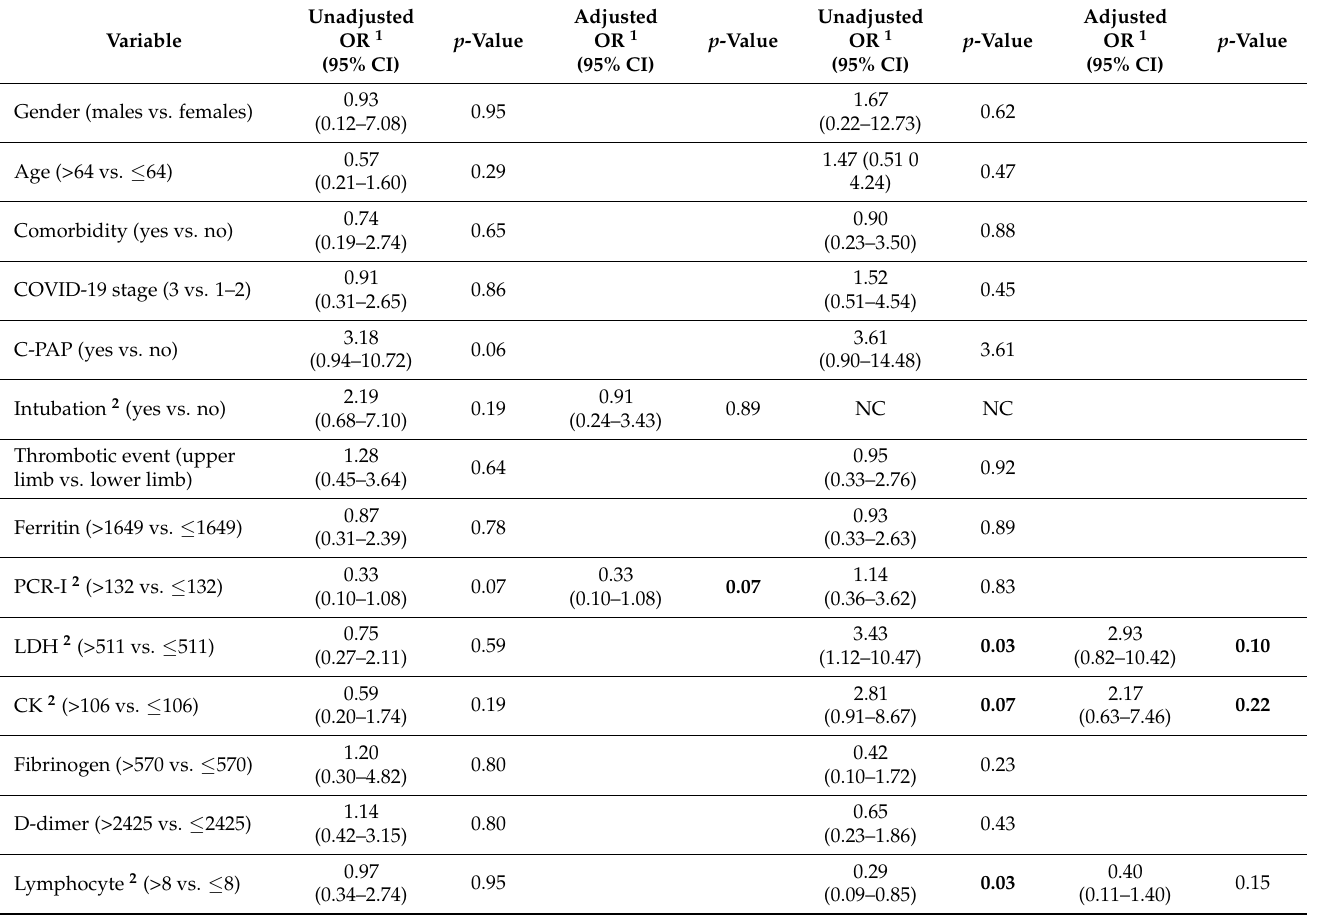
Table 6. Univariate and multivariable logistic regression analysis with the length of